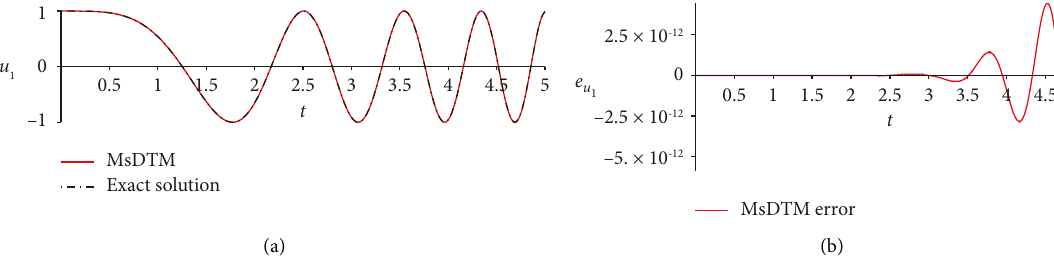
(a) and the absolute error e u 1